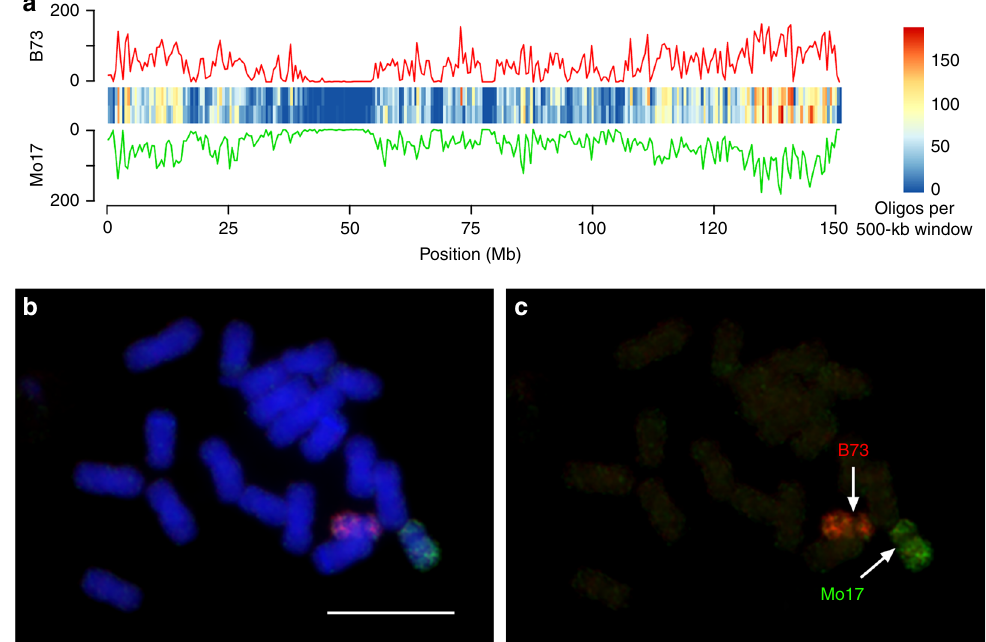
Fig. 2 Development of hapB and hapM probes. a Distribution of 14,498 oligos (red) of probe hapB and 13,753 oligos (green) of probe hapM on maize chromosome 10. The chromosome was divided into 500-kb windows and number of oligos was calculated for each window. The distribution of the number of oligos is shown in the line plot and heatmap. y -axis is the number of oligos in each 500-kb window. b Oligo-FISH on metaphase chromosomes from a B73 × Mo17 hybrid using hapB (red) and hapM (green). Bar = 10 μ m. c The oligo-FISH signals were digitally separated from panel ( b ). The original gray- scale images used to generate the color image in Fig. 2b are provided as a Source Data fi